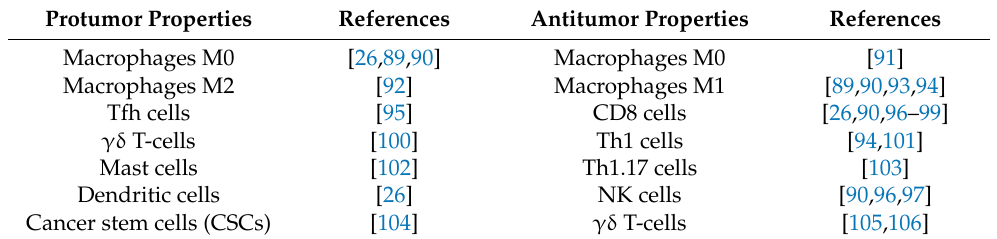
Table 1. MDR-positive immune cells associated with the tumor microenvironment of osteosarcoma. Protumor